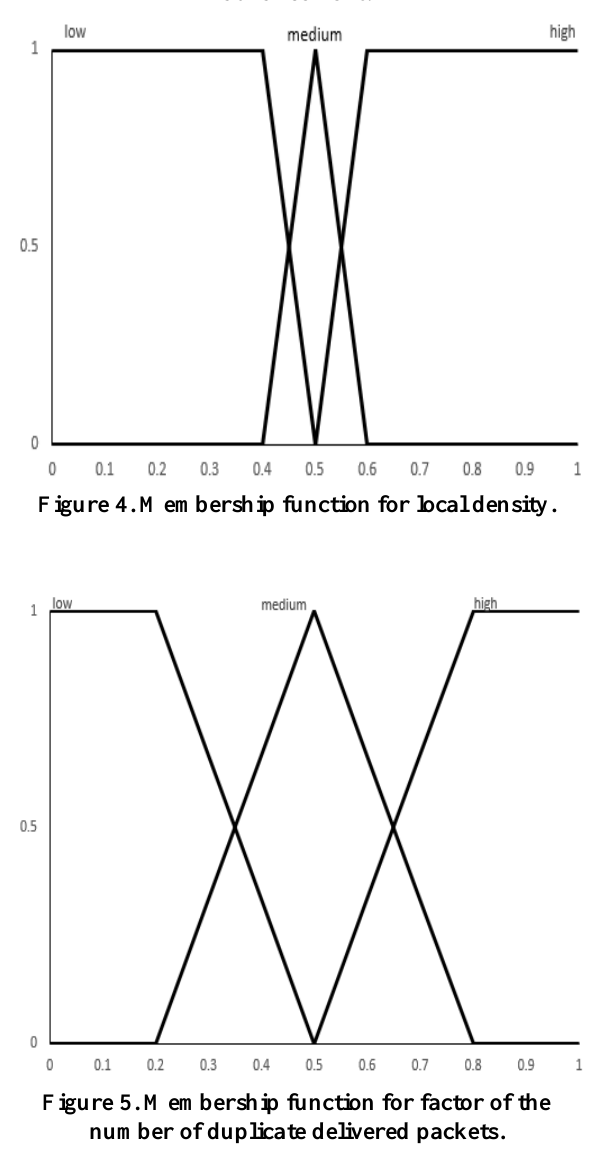
Figure 3. Membership function for the packet advancement.